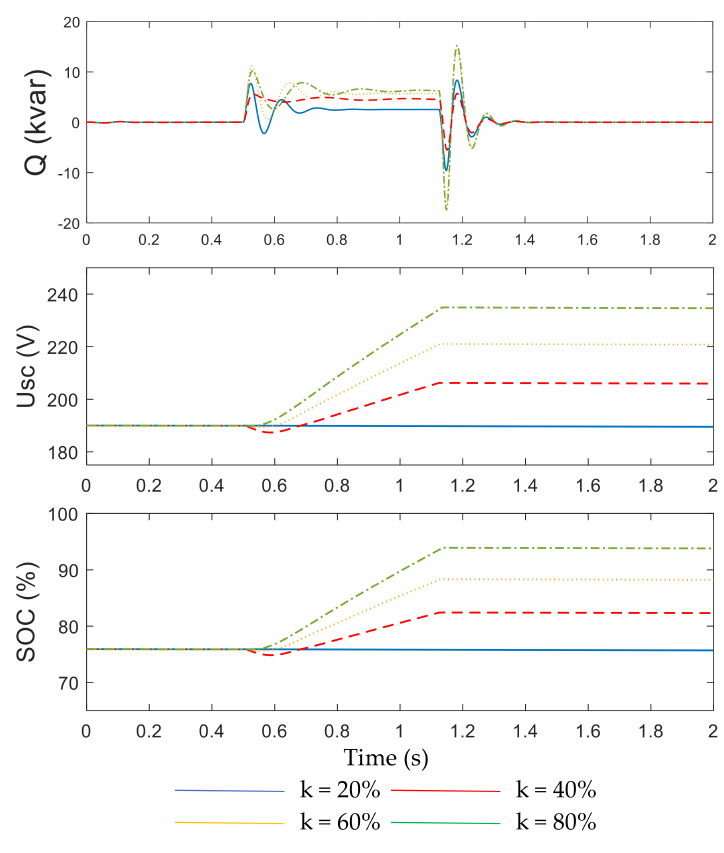
Figure 13. The simulation results of the overspeed-while-storing control.